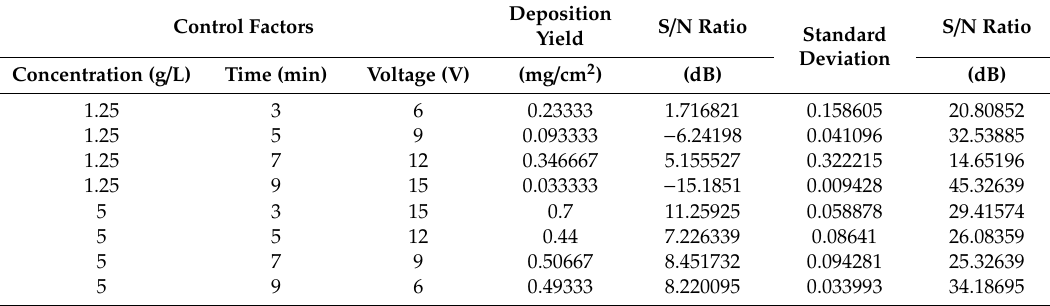
Table 3. Experimentally calculated deposition yield and corresponding standard deviation.